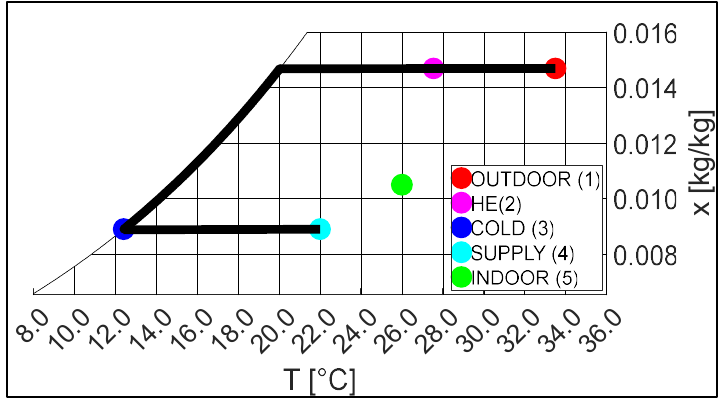
Figure 7. Transformations for HVAC with traditional dehumidification (case B, scenario 1).